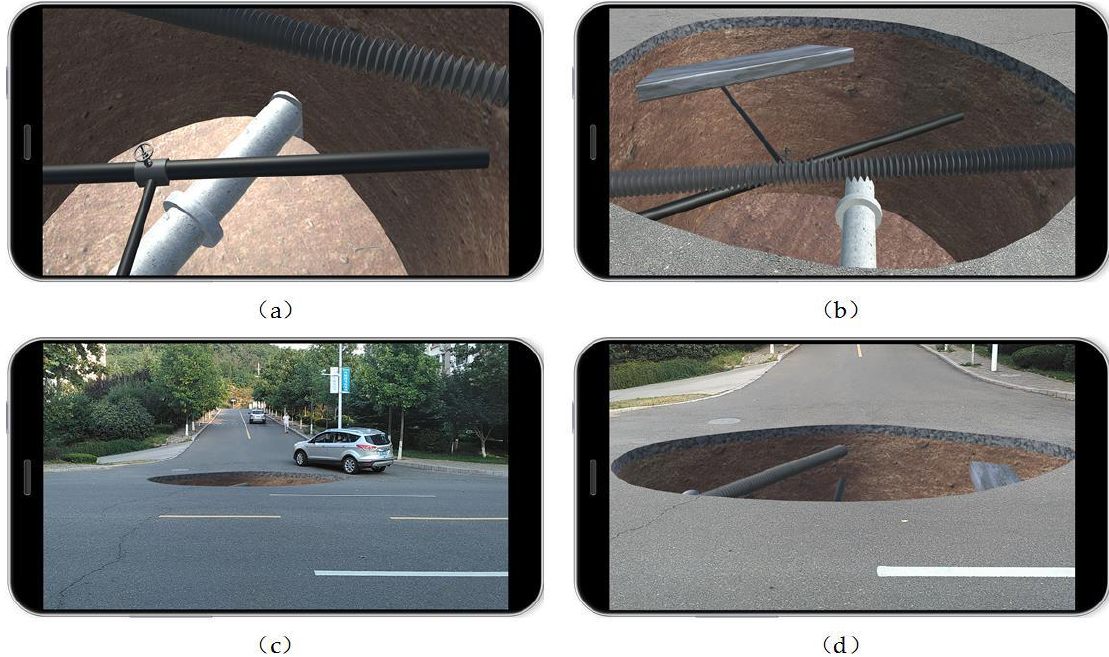
Figure 9. Underground pipelines in a road: ( a ) on the top of the pipelines; ( b ) at the edge of the hole; ( c ) far away from the hole; ( d ) the whole area of the pipelines.